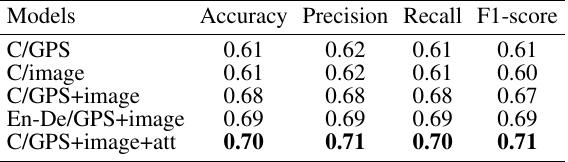
Table 4. Sequence detection results of different models.